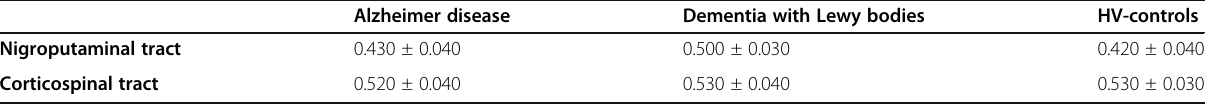
Table 2 Diffusion metrics (fractional anisotropy) values of nigroputaminal and corticospinal tracts across patients and